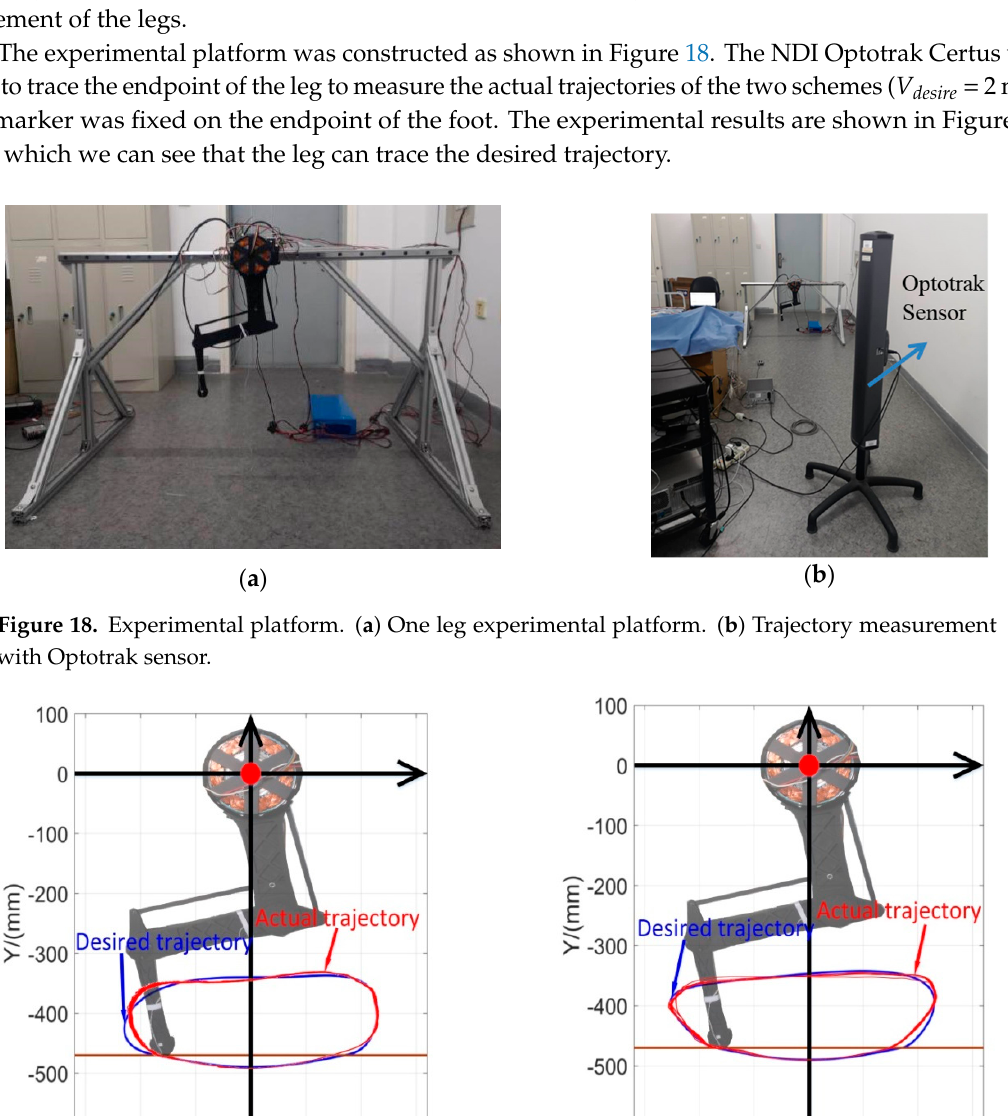
Table 3. Energy consumption of two schemes in V desired =2m/s within 17s. Mechanical energy consumption(J)